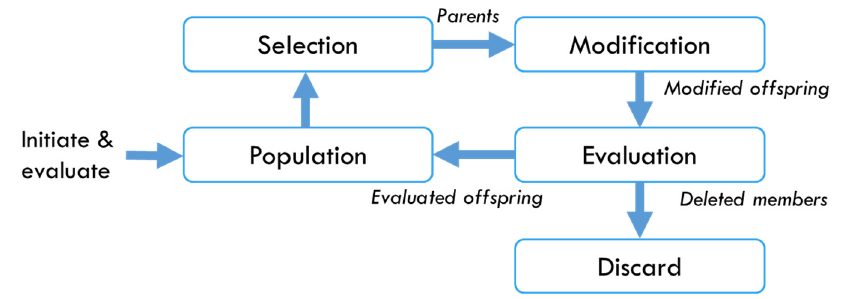
Figure 8. The GA evolutionary cycle.